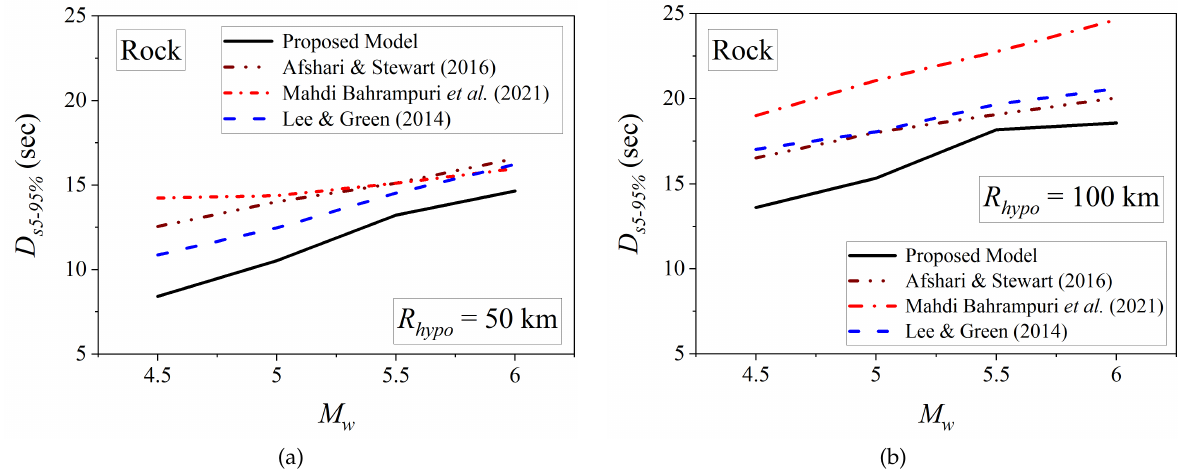
Fig. 10. Comparison of D s 5 − 95% between this study and existing models for (a) R hypo = 50 km, and (b) R hypo = 100 km.